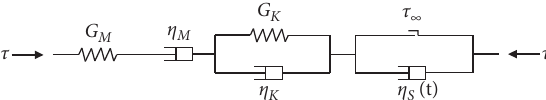
Figure 5: Shear creep model of the fractured rock mass.